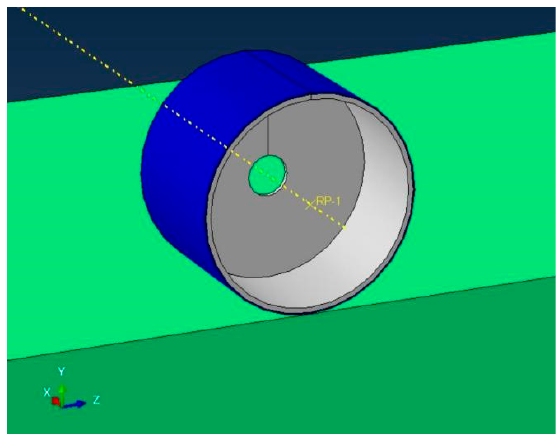
Figure 2. Finite element model of “machine-pavement” system.